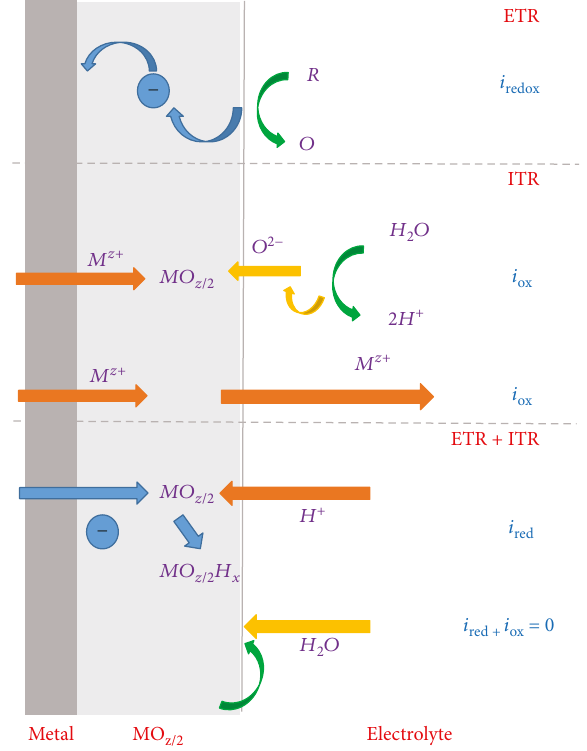
Figure 1: Scheme of the several ion-transfer reactions (ITRs) and electron-transfer reactions (ETRs) during the anodization